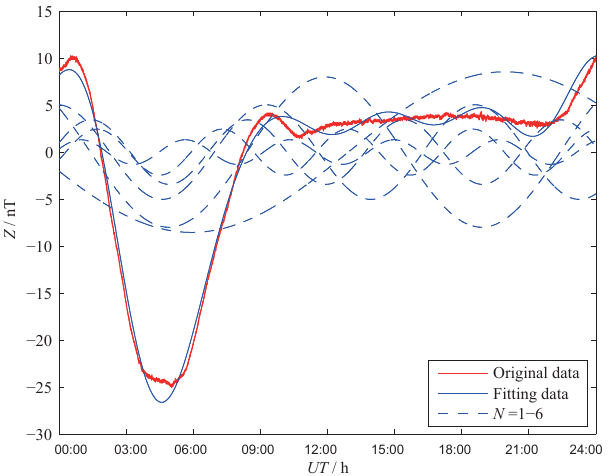
Figure 1. Fitting results of first six harmonic components. netic diurnal variation by the use of FFT with a degree of 250; the residual error may represent changes in background noise. The testing result showed that this approach to esti- mate background noise in geomagnetic data is effective.